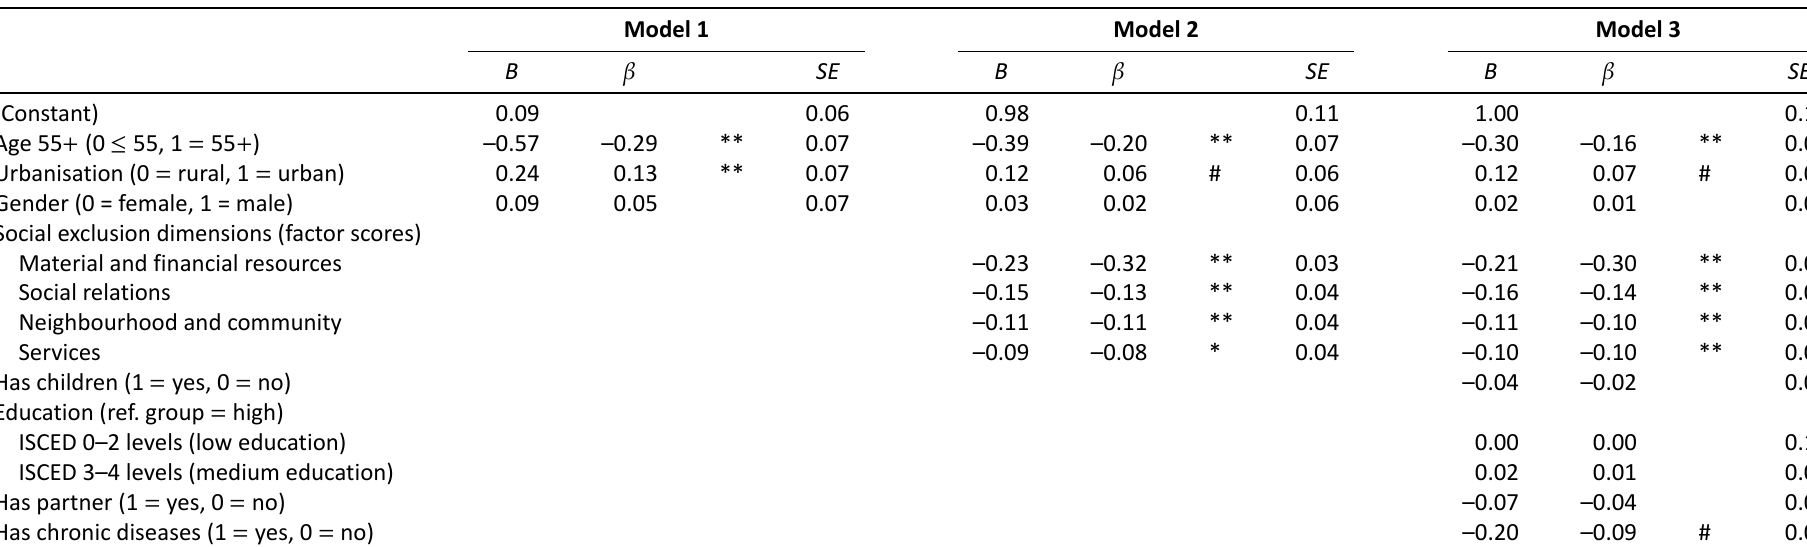
Table A2. Summary of the hierarchical regression analysis for variables predicting mental wellbeing (N = 726).